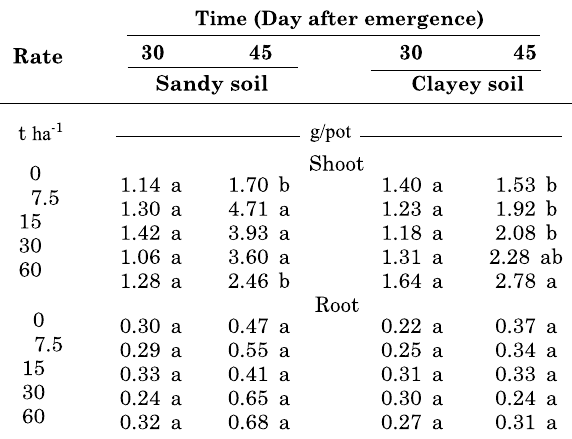
Table 4. Changes in shoot and root dry weight of cowpea grown in soils amended with